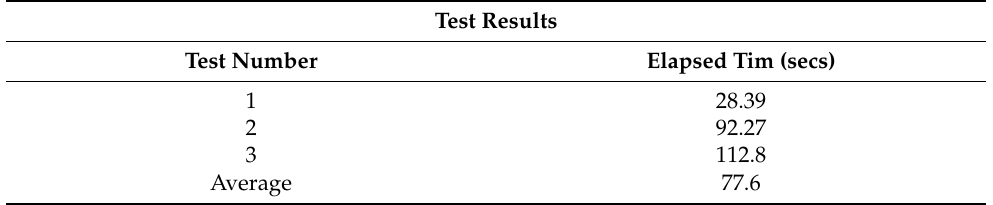
Table 2. IoT gateway redeployment times.